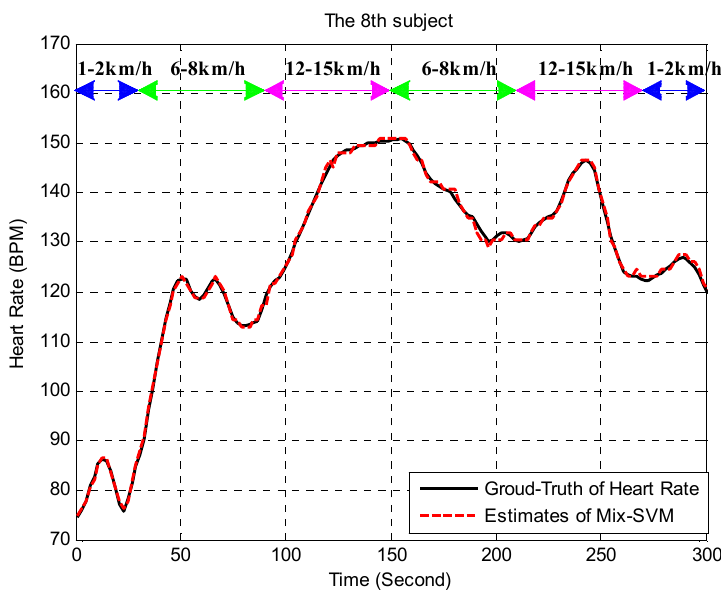
Figure 4. Estimation result on subject 8.